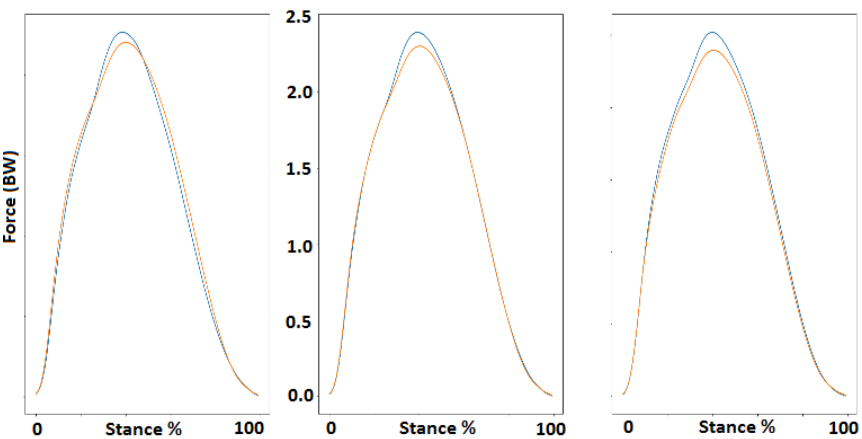
Figure 15. Predicted GRFs (orange) vs. actual GRFs (blue). Left (8 km/h), center (10 km/h), and right (12 km/h). Table 1. RMSE ( ±SD ) between measured and predicted GRFs.